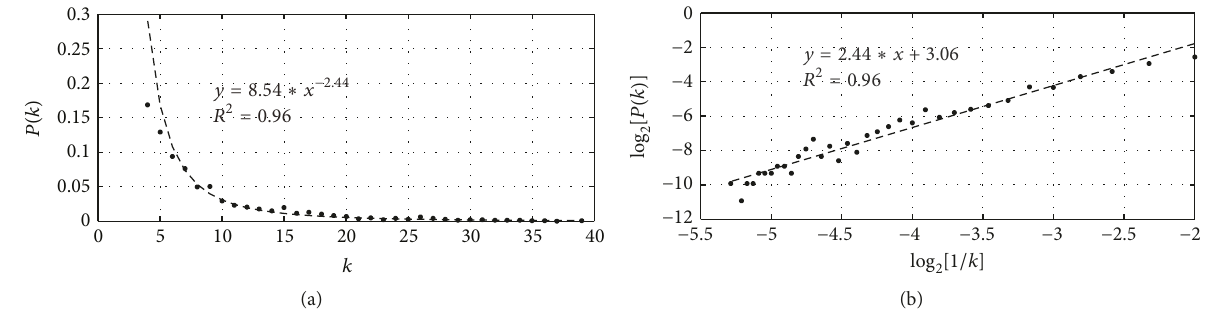
Figure 3: (a) 𝑃(𝑘) versus 𝑘 plot for a cluster (b) log 2 [𝑃(𝑘)] versus log 2 [1/𝑘] plot for the same cluster.